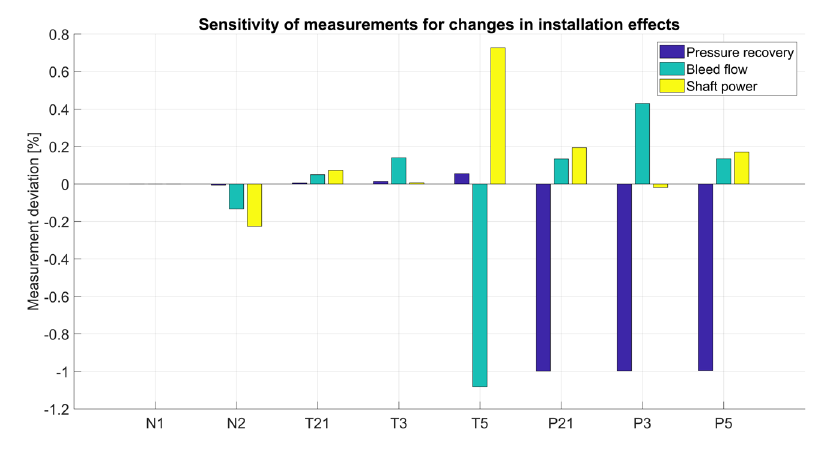
Figure 5. Sensitivity of measurements at different degradation patterns.